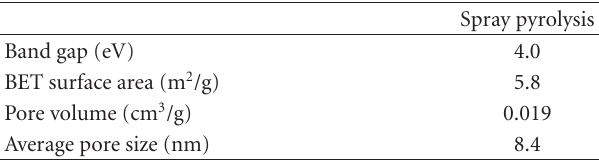
Table 1: Physical properties of naked sodium tantalates synthesized by spray pyrolysis (NaTaO 3 powder synthesized by spray pyrolysis;